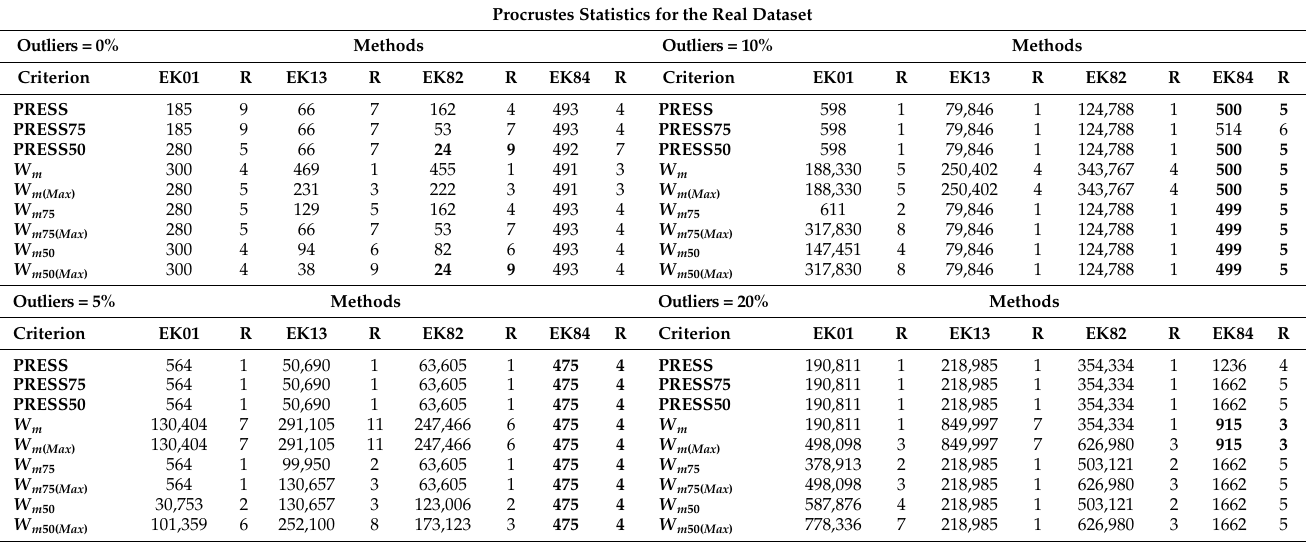
Table 3. Procrustes statistics for the real